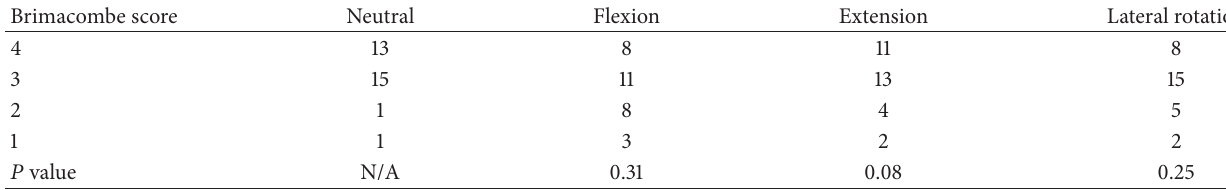
Table 5: Fibreoptic view of glottis with I-gel.